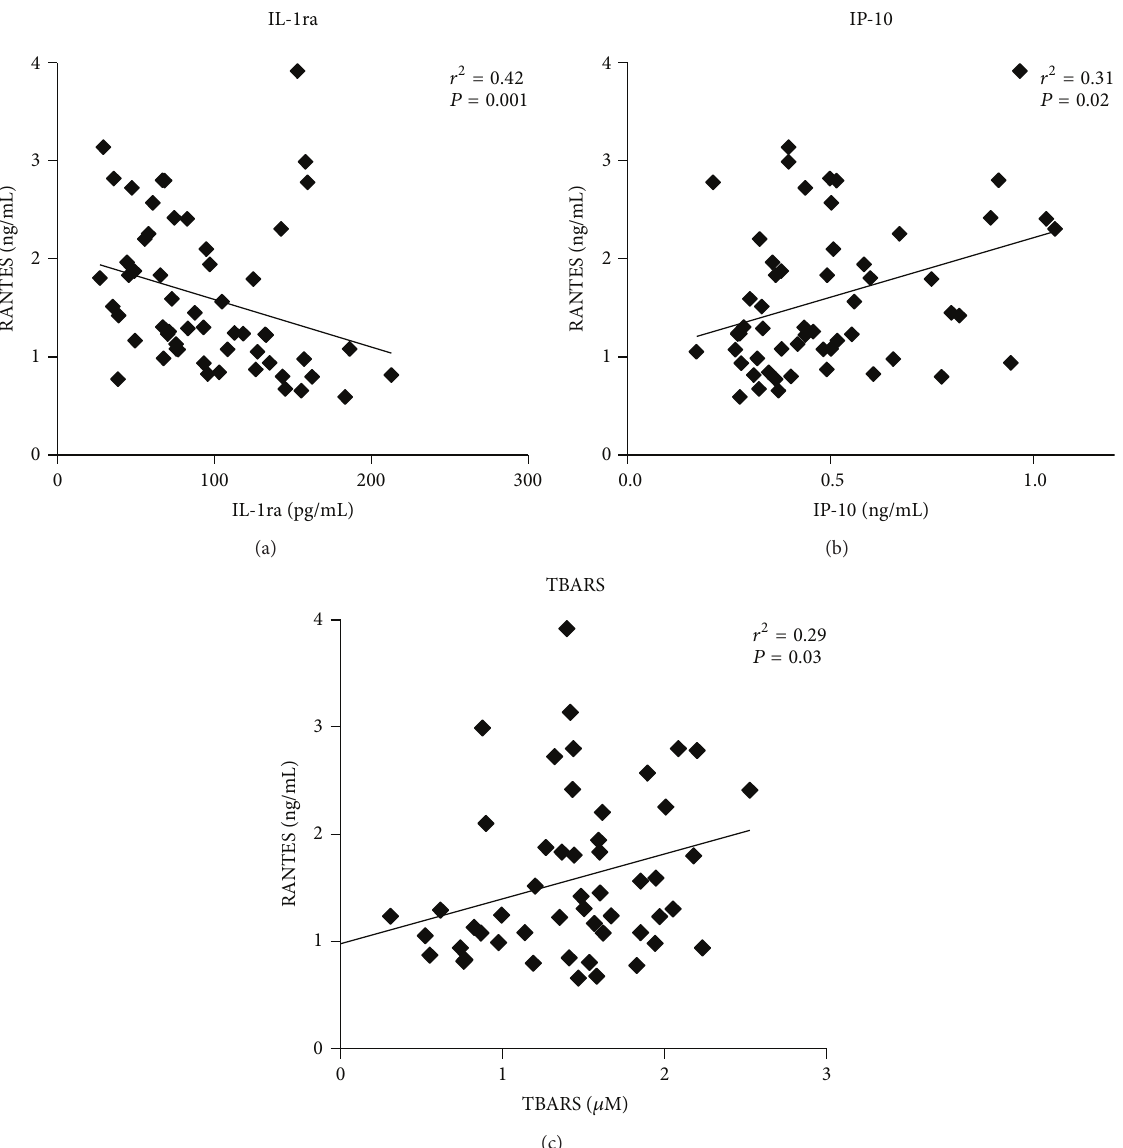
Figure 1: Correlation analysis of circulating RANTES with key inflammatory makers. In a mixed population of lean ( 𝑛 = 17 ) and obese ( 𝑛 = 40 ), circulating RANTES correlated negatively with the IL-1ra levels and positively with IP-10 chemokine levels and TBARS activity. Correlations were assessed using Spearman’s rank correlation